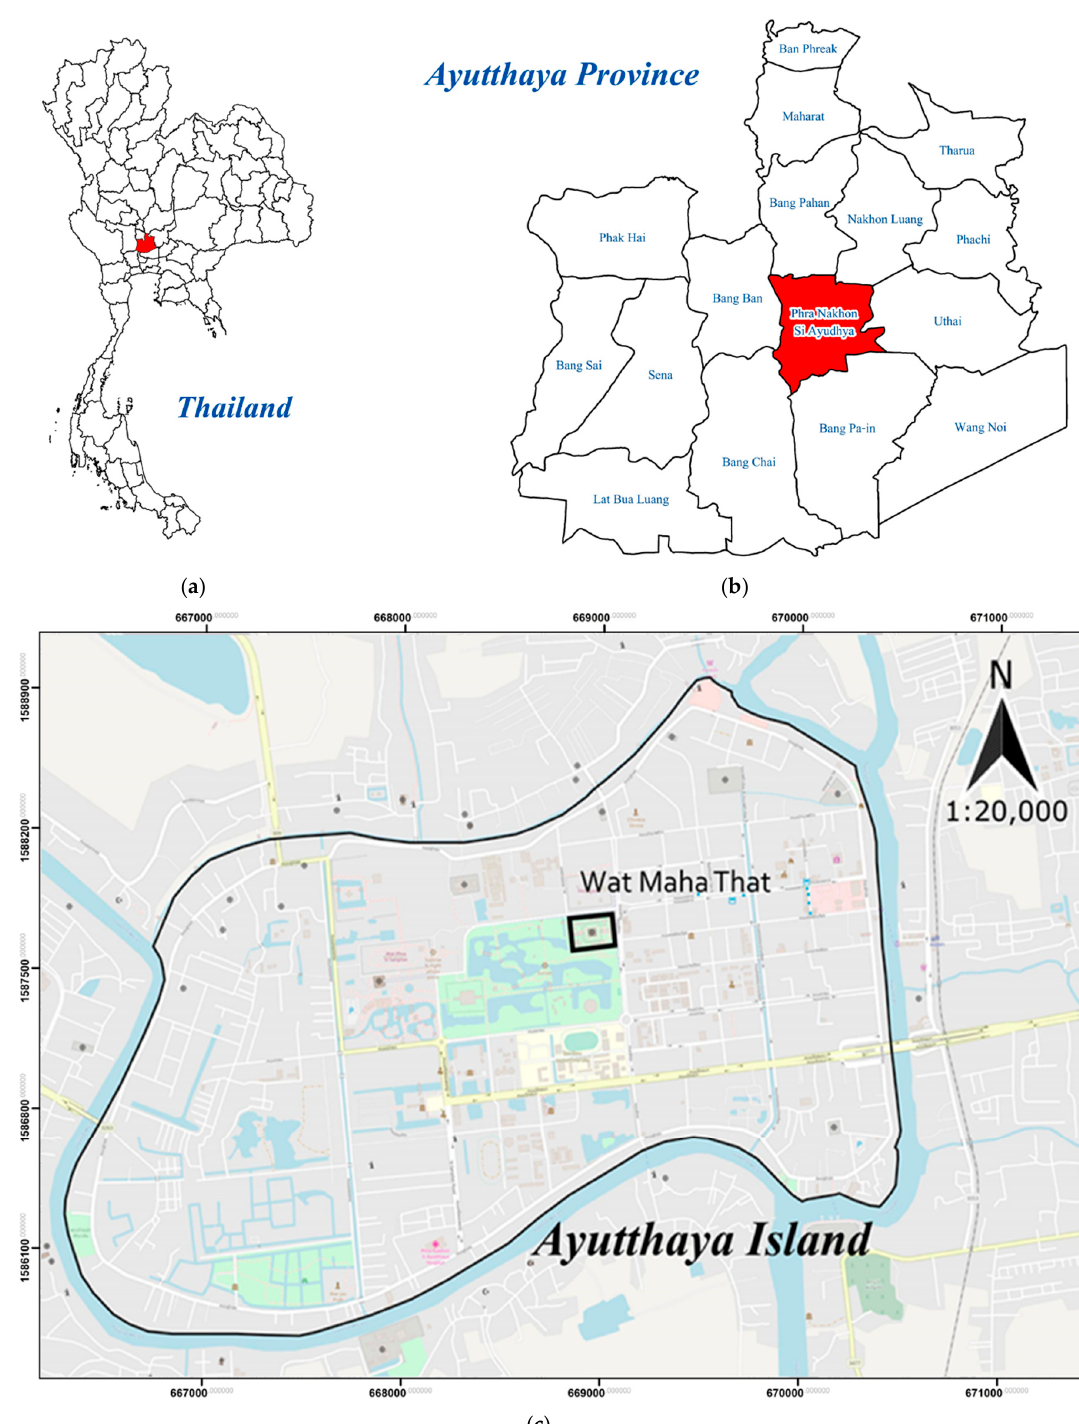
Figure 1. Aerial overview of the study area, Wat Maha That, Ayutthaya Island, Ayutthaya Province. ( a ) Map of Thailand. ( b ) Map of Ayutthaya Province. ( c ) Study area in Wat Maha That .